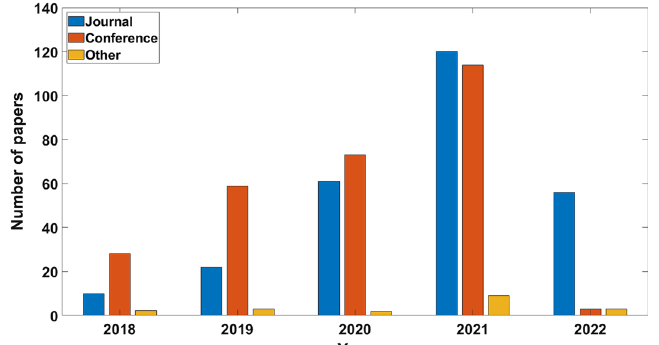
Fig. 4 Number of papers referring to CF